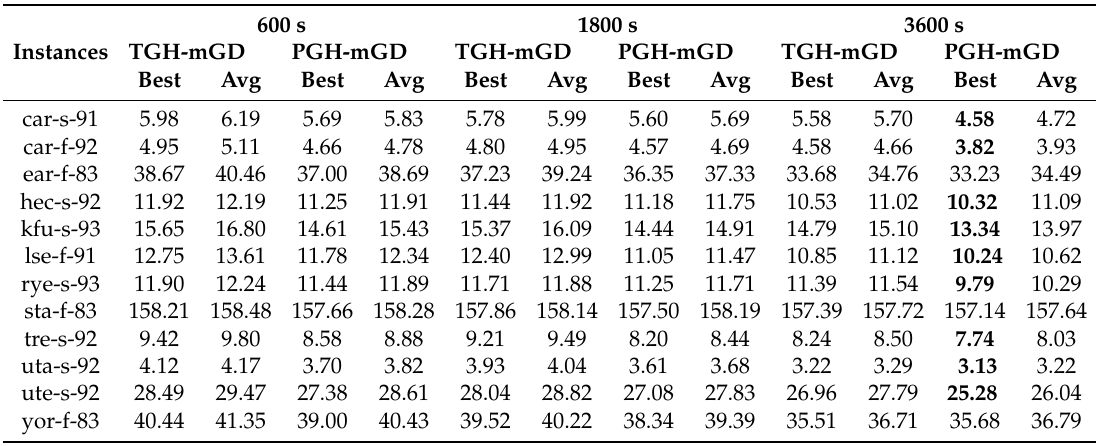
Table 4. Penalty values of Toronto dataset for different termination